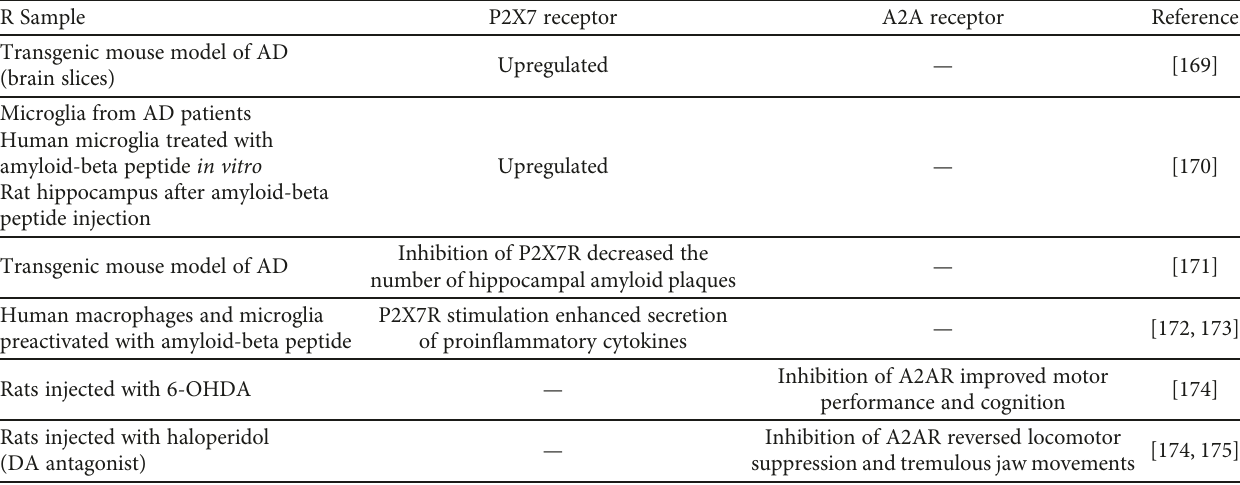
Table 3: Role of purinoreceptors in experimental models and patients with Alzheimer ’ s disease (AD) and Parkinson ’ s disease (PD).